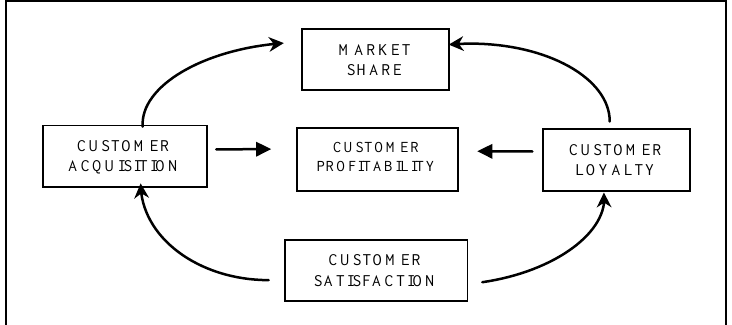
Figure 1: The Customer Perspective According to Kaplan And Norton